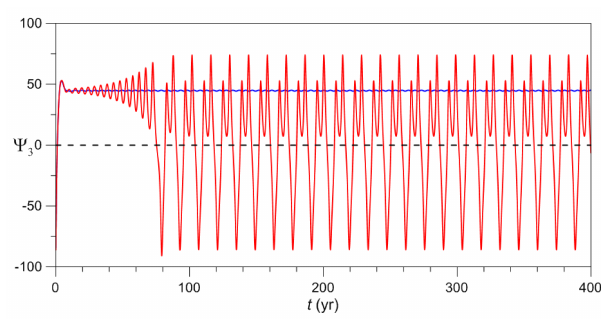
Figure 12. Fixed point P 0 of the autonomous case, with ε = 0. Time evolution of (cid:57) 3 for the trajectory initialized at P 0 = ( − 16 , − 83 ) (blue line) and at a nearby point (solid red line) for γ = 1 . 1 and T p = 30 years.